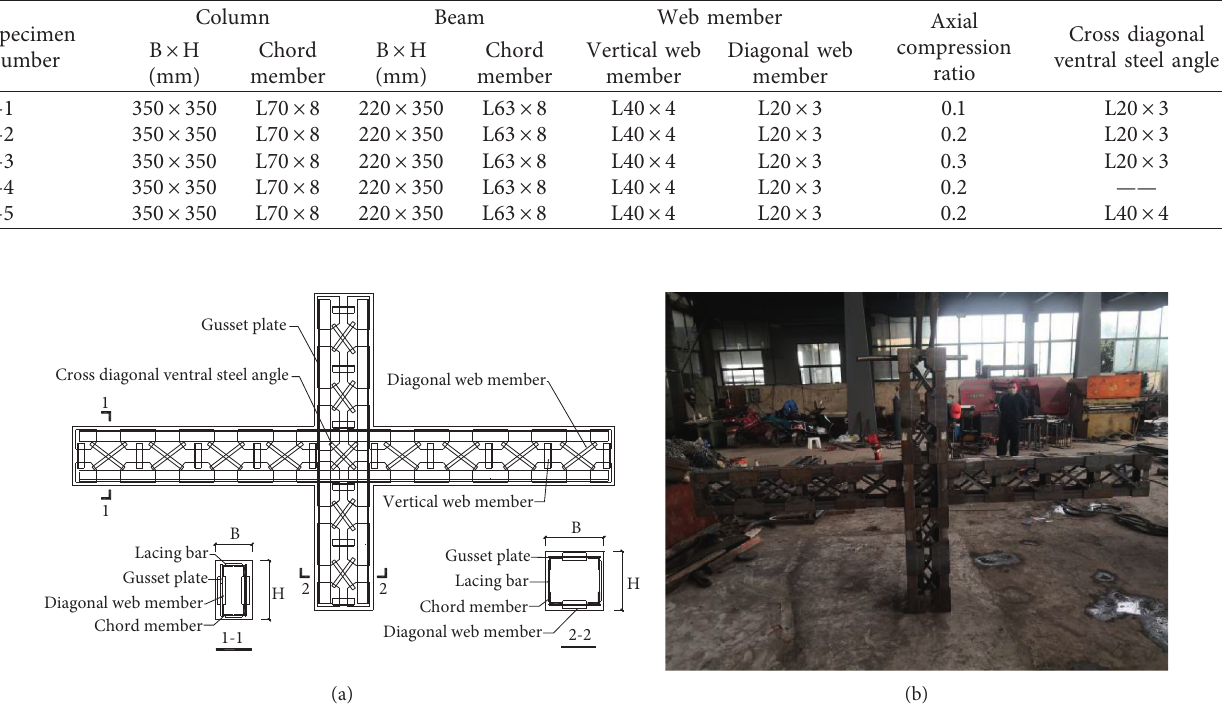
Figure 1: Design of joint specimen: (a) reinforcement style and (b) photograph of reinforcement skeleton before casting.